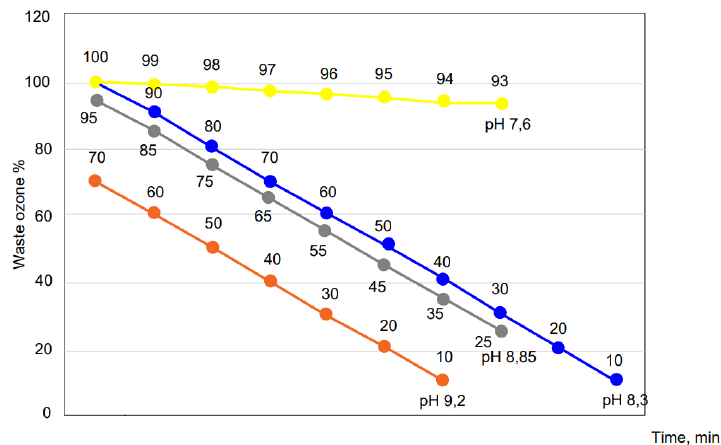
Figure 4. D ecomposition of ozone in water depending on the рH . Figure 4. Decomposition of ozone in water depending on the pH.